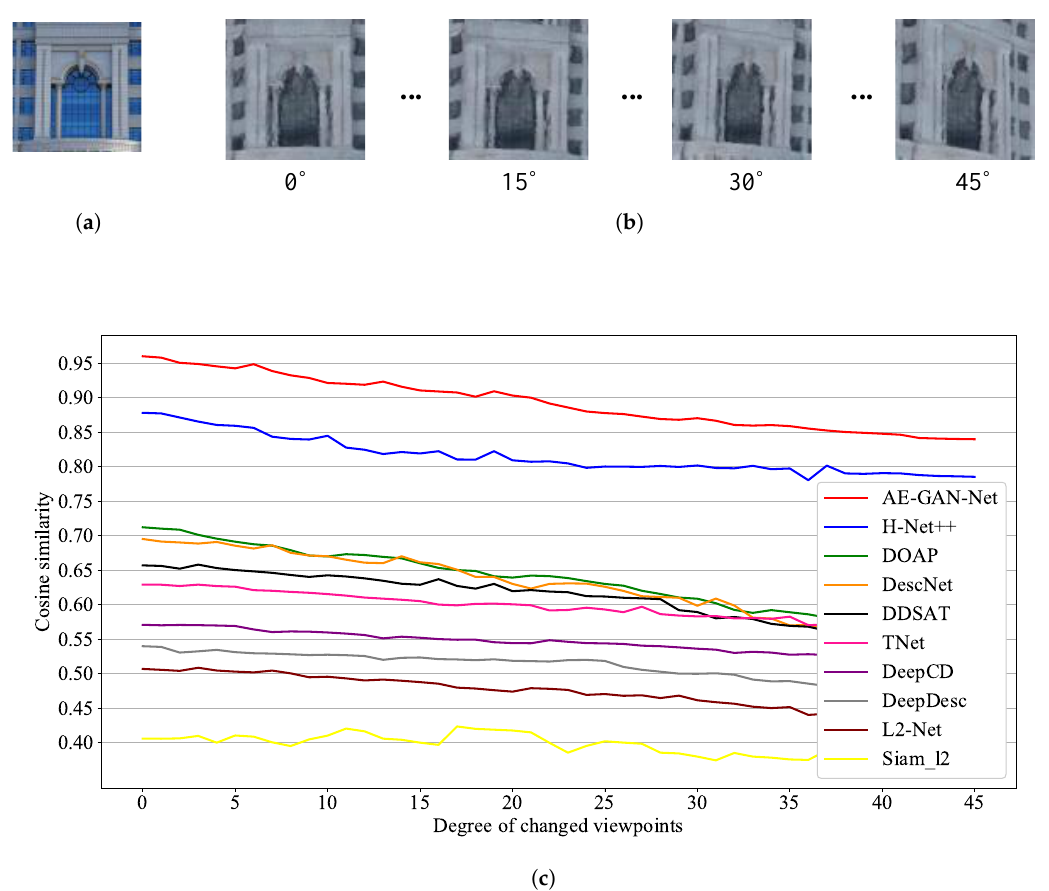
Figure 10. The cosine similarity of varied image patch pairs with different viewpoints. ( a ) Fixed patch. ( b ) Gradually varied rendered image patches with different viewpoints. ( c ) The cosine similarity of ( a ) and each patch in ( b